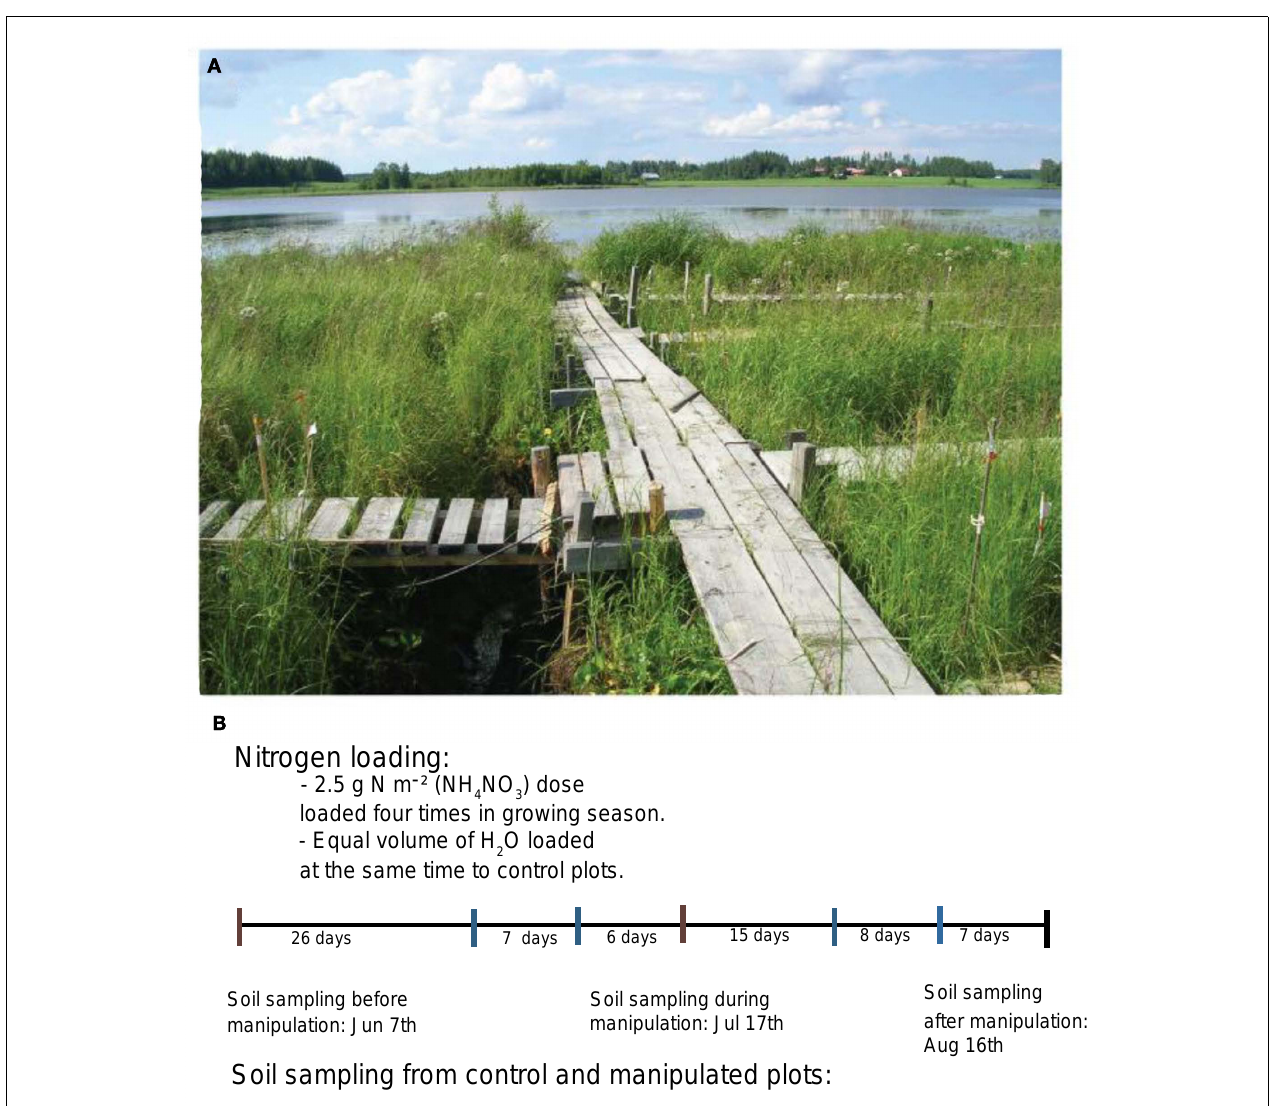
FIGUREA1 | (A) The littoral wetland of Lake Kevätön in July 2007. For experiment, three control and three manipulated plots of 1.44m 2 were established to area having equal water level and vegetation.The chambers for measurements of in situ CH 4 fluxes were inserted into study plots 2weeks before the experiment. Soil sampling and in situ CH 4 flux measurements were taken from boardwalks to omit disturbance of the